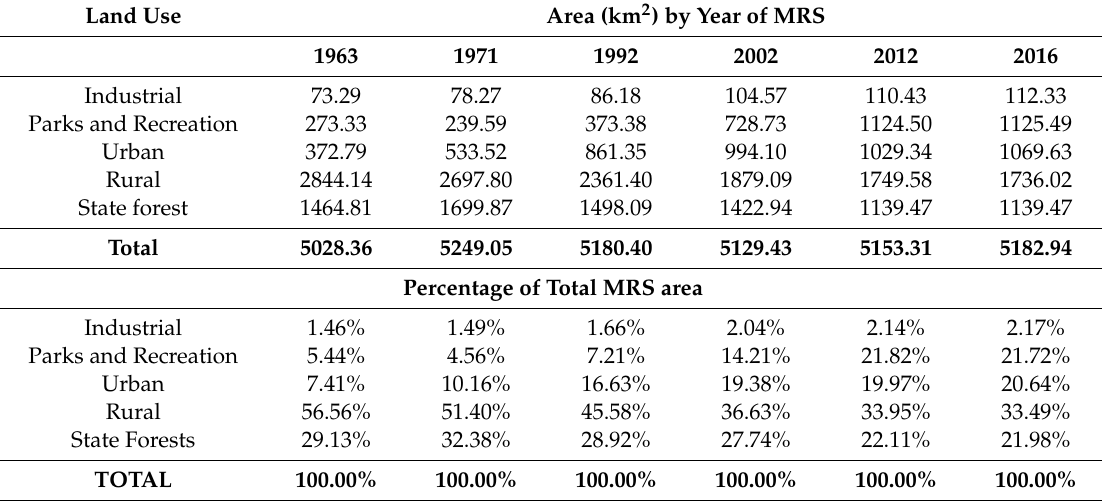
Figure 5. Areal land use changes between 1963 and 2016. (Percentages signify the proportion of urban land in the PMR). Source: Made by author. Table 1. MRS land areas between 1963 and 2016 .